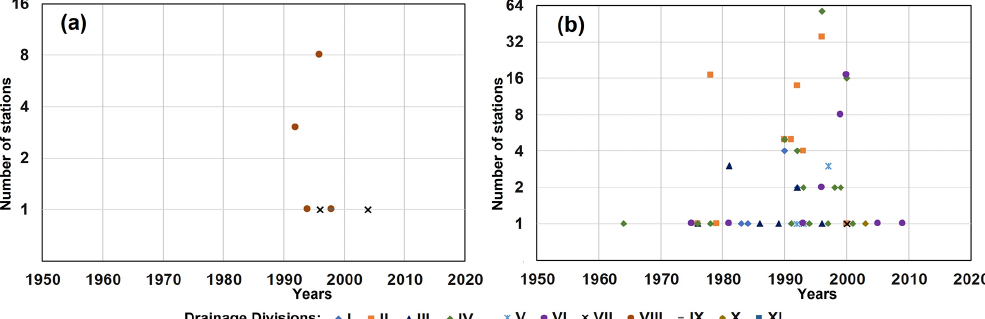
Figure 10. The timing of step changes and the number of stations with step changes for different drainage divisions with (a) increasing and (b) decreasing changes in the water